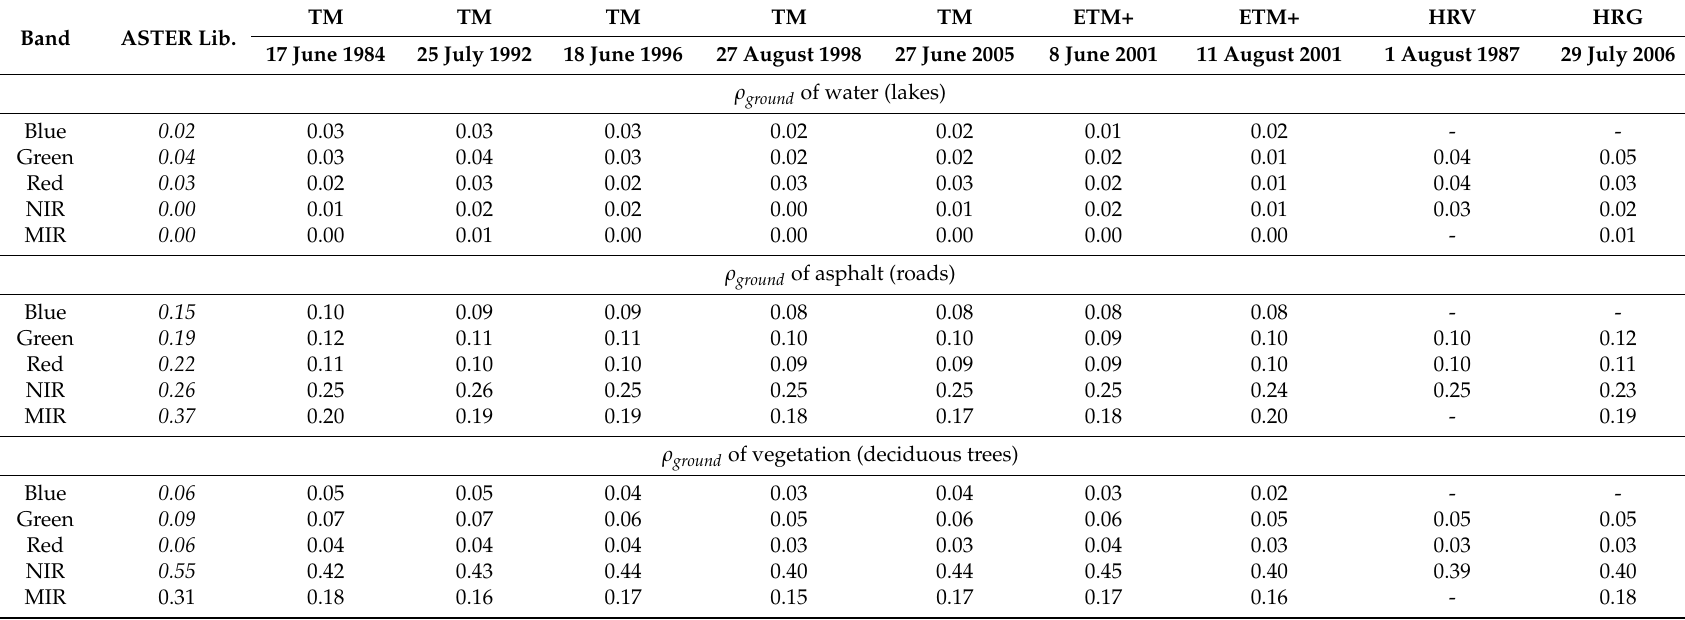
Table 6. Averages of ground reflectances of the selected materials on Landsat and SPOT